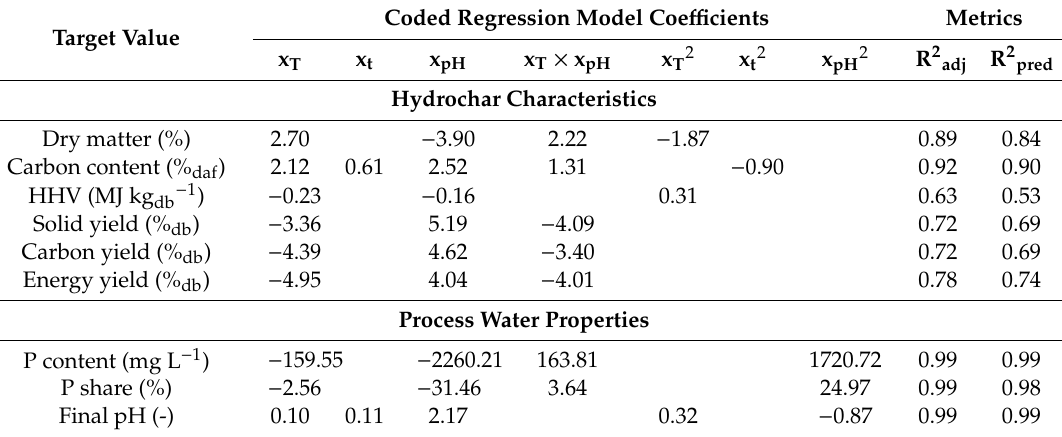
Table 2. Coded regression model coe ffi cients for hydrochar (HC) and process water